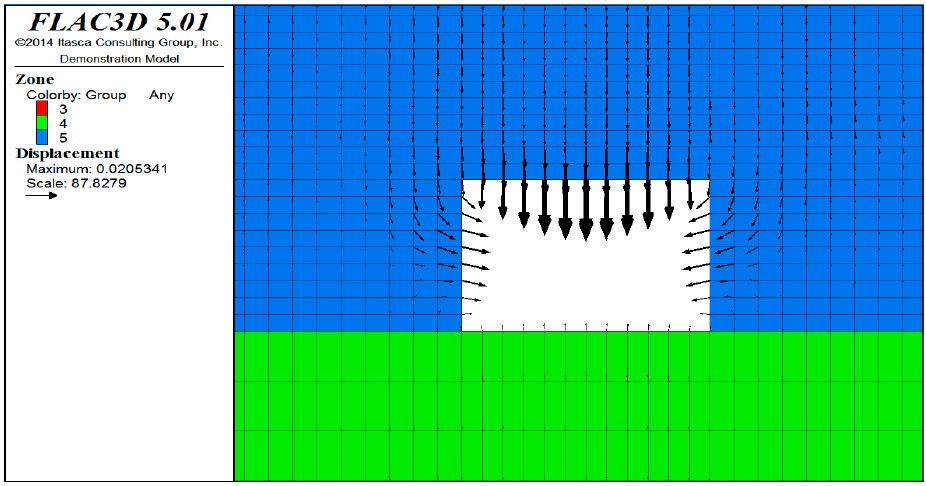
Figure 9. Vector diagram of deformation and displacement.